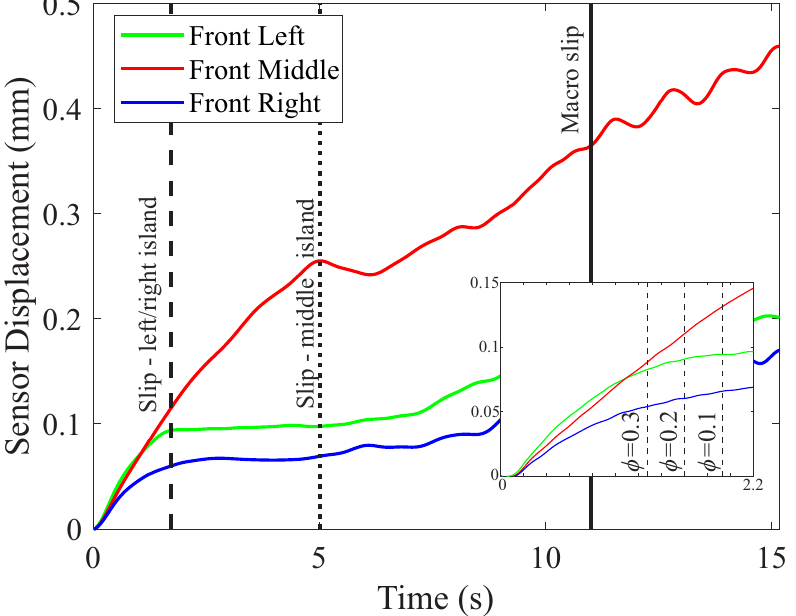
Figure 3. Example of typical displacement characteristics for the front-left, middle, and right islands of the grasper under a 20 N clamp load with a retraction speed of 2 mm/s (using Mat A). The inset shows how the variation in the slip ratio changes the time at which the incipient slip of the edge islands is